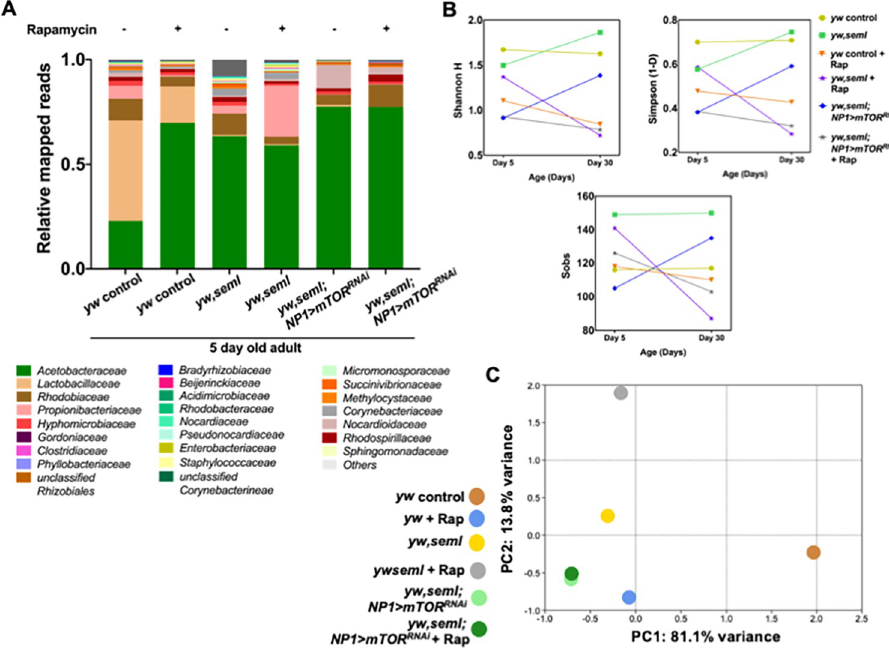
Fig 4. Inhibition of Drosophila TOR does not restore bacterial diversity. (A) The graph represents the relative abundance of bacterial families observed in the guts of 5 - day old female yw , ywseml (females) and ywseml; NP1GAL4 > UAS-TOR RNAi flies (males) with (+) or without (-) rapamycin treatment revealed by 16S next-generation sequencing. The x axis represents y strains of different genotypes and treatments, and the y axis represents relative mapped reads. (n = 40 guts/strain/treatment). (B) The graphs represent alpha diversity indices of female yw , ywseml and ywseml; NP1GAL4 > UAS-TOR RNAi across two treatments (with or without rapamycin). (A) Simpson’s (1-D) index, (B) Shannon H index an (C) Total number of bacterial families observed (Sobs). (n = 40 guts/strain/treatment). (C) The graph represents PCA plot (Beta diversity) of female yw , ywseml and ywseml; NP1GAL4 > UAS-TOR RNAi across two treatments (with or without rapamycin; n = 40